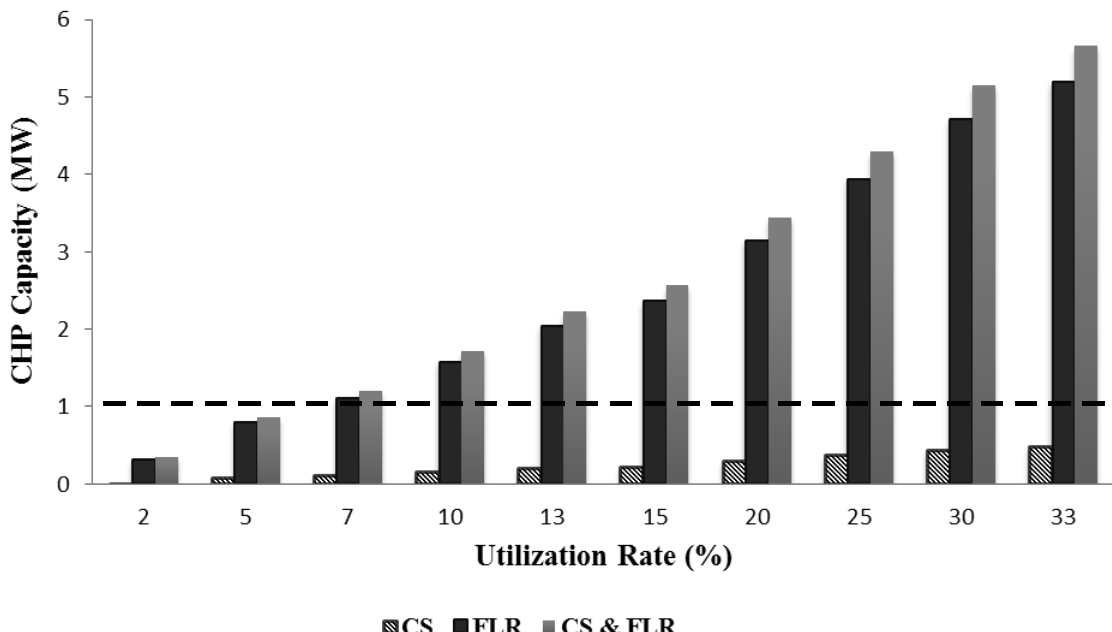
Figure 2. The capacities of the CHP plant in Scott county based on different utilization rates (%) of biomass feedstock. “---” Represents the existing capacity of the CHP plant in Scott county (1 MW).